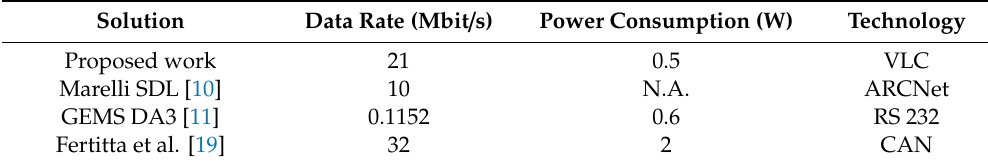
Table 3. Comparison with the state of the